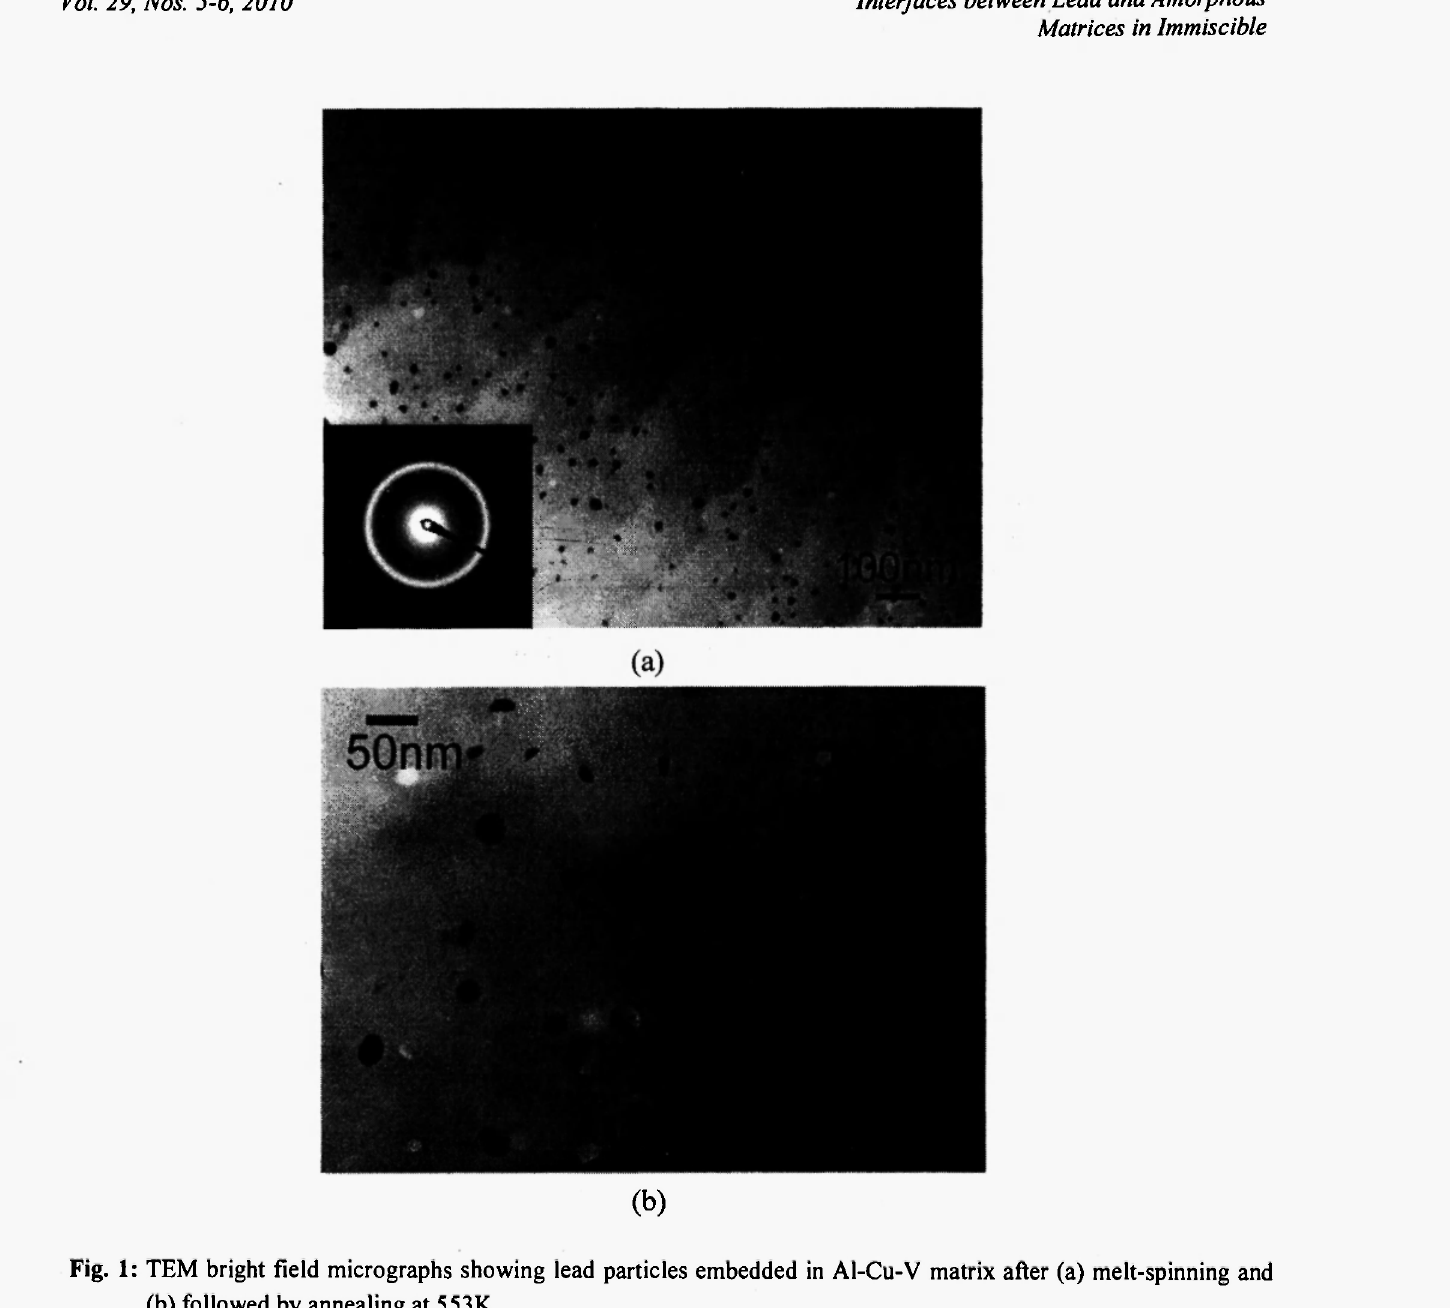
Fig. 1: TEM bright field micrographs showing lead particles embedded in Al-Cu-V matrix after (a) melt-spinning and (b) followed by annealing at 553K Upon cooling after melting, no clear exothermic peak indicating solidification was observed /16/. This indicates that solidification of the lead nanoparticles occurs over a large temperature range. No clear peak can also be seen as a very broad peak, which indicates a large contact angle of solid nucleus on the matrix interface /18,19/. A large contact angle is associated with high interfacial